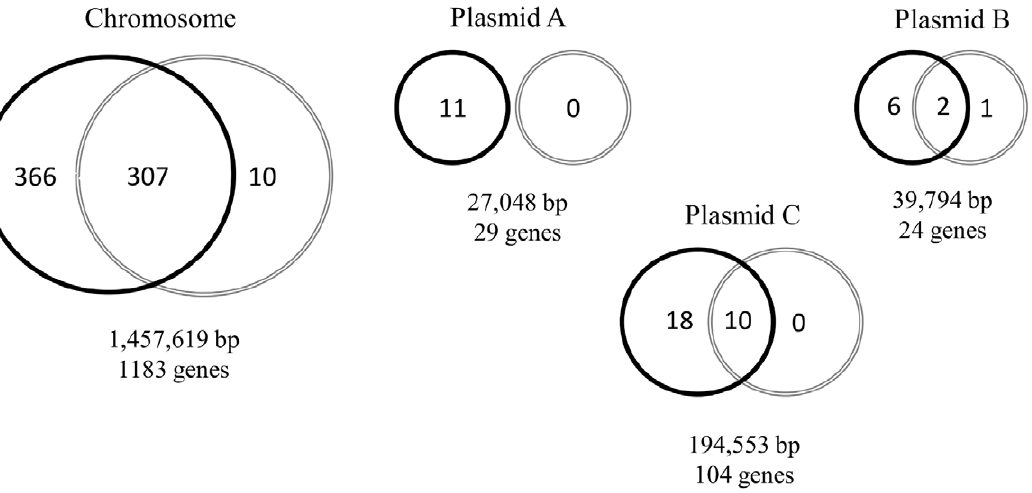
Figure 1. Schematic representation of the L.intracellularis genome. Distribution of genes expressed by the pathogenic (black circles) and the non-pathogenic (gray circles) variants. Overlapping zones represent genes expressed in both variants.